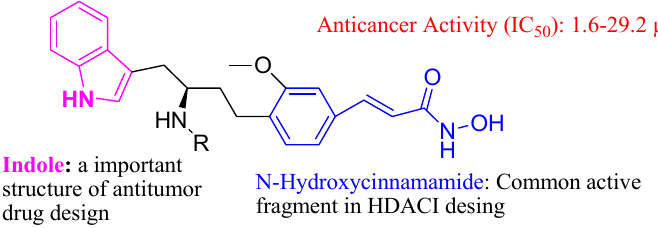
Figure 28. N -Hydroxycinnamamide-based histone deacetylase